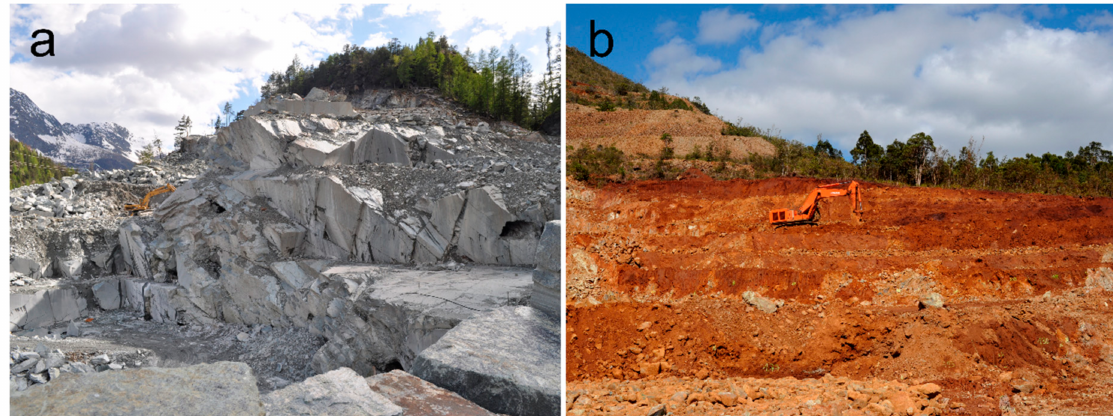
Figure 1. Mining sites. ( a ) Serpentine quarry at Valmalenco (central Alps, northern Italy); ( b ) Ni-open pit of Tontouta (Massif du sud, New